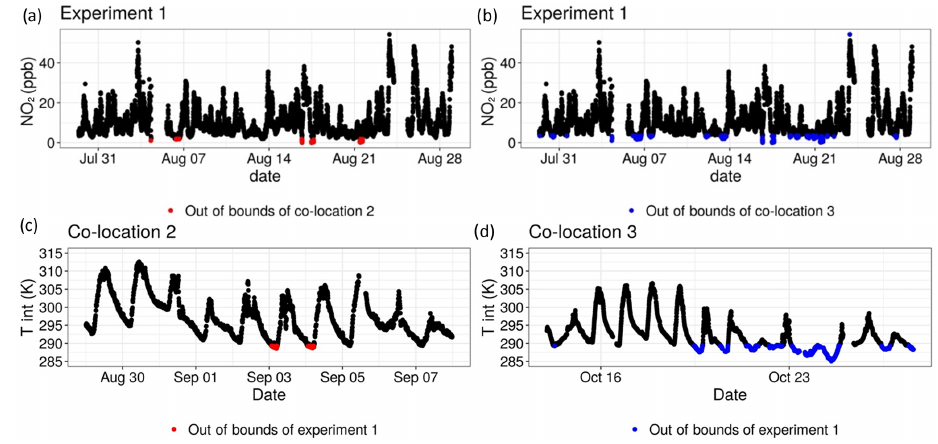
Figure 8. (a, b) Example time series plots of the experimental data with points out of bounds of the second and third co-locations flagged, respectively. (c) Time series plot of the second co-location with points flagged for being out of bounds of the experimental dataset. (d) Time series plot of the third co-location with points flagged for being out of bounds of the experimental